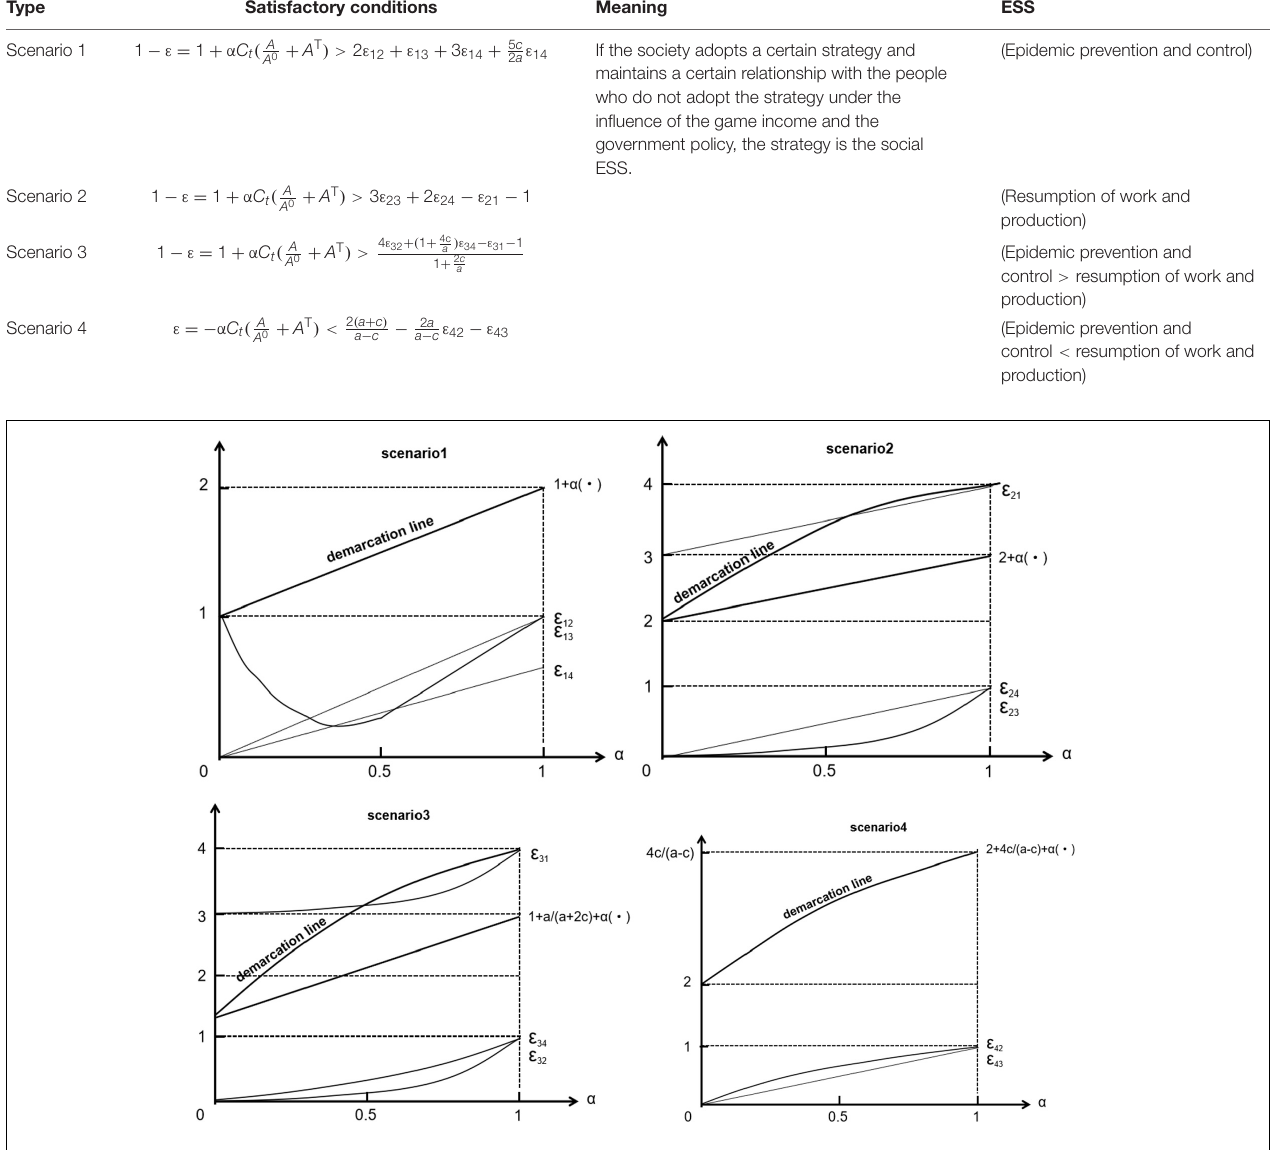
FIGURE 2 | Strategic changes with government